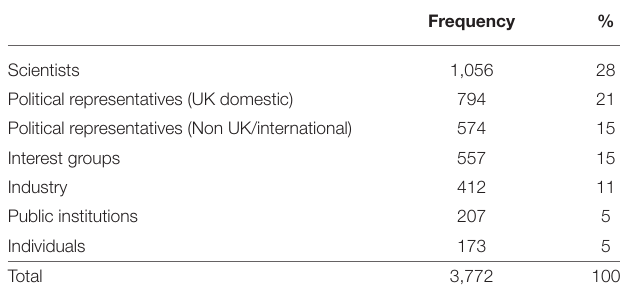
TABLE 1 | Frequency of news actors.